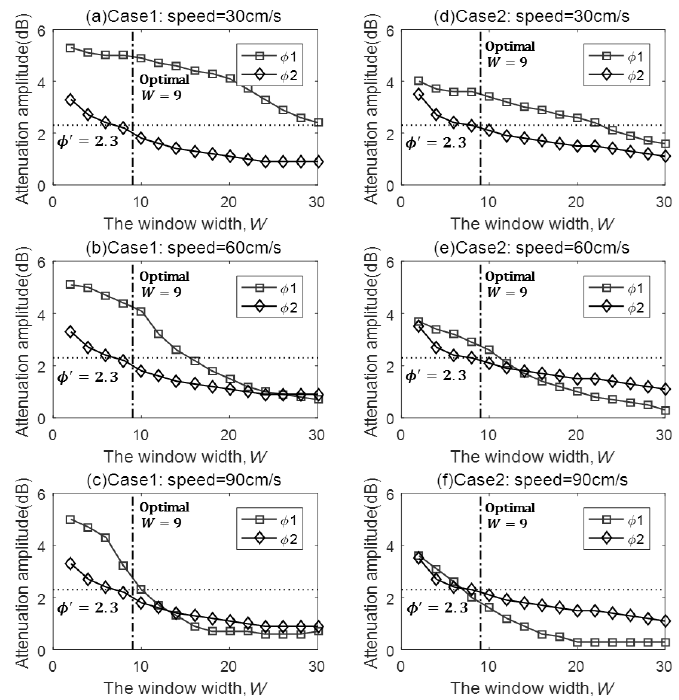
Figure 5. The attenuation amplitudes 𝜙1 and 𝜙2 under various speeds in the two cases.